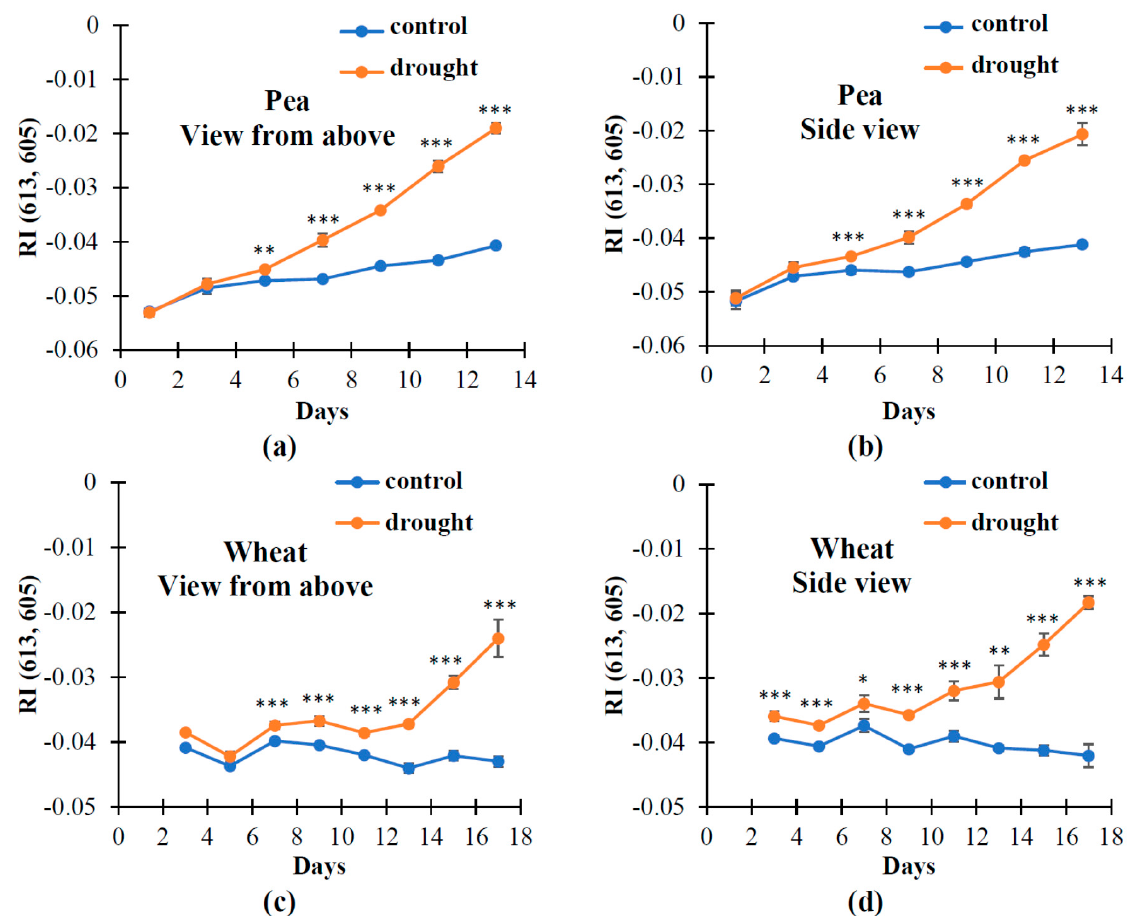
Figure 3. The influence of the soil drought on RI (613, 605) in pea and wheat plants cultivated under controlled conditions. ( a ) The measurement of RI (613, 605) in pea at the view from above; ( b ) the measurement of RI (613, 605) in pea at the side view; ( c ) the measurement of RI (613, 605) in wheat at the view from above; ( d ) the measurement of RI (613, 605) in wheat at the side view. * p < 0.05; ** p < 0.01; *** p < 0.001.